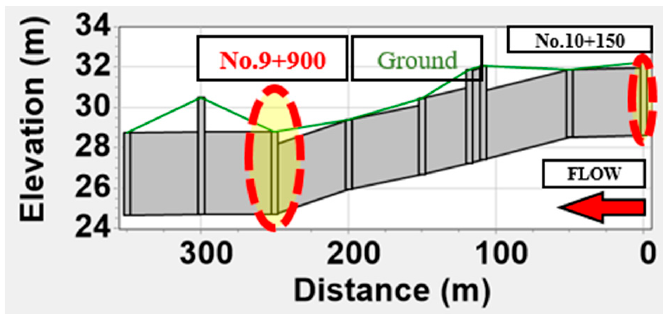
Figure 2. Longitudinal section of the Oncheon River area (partial).